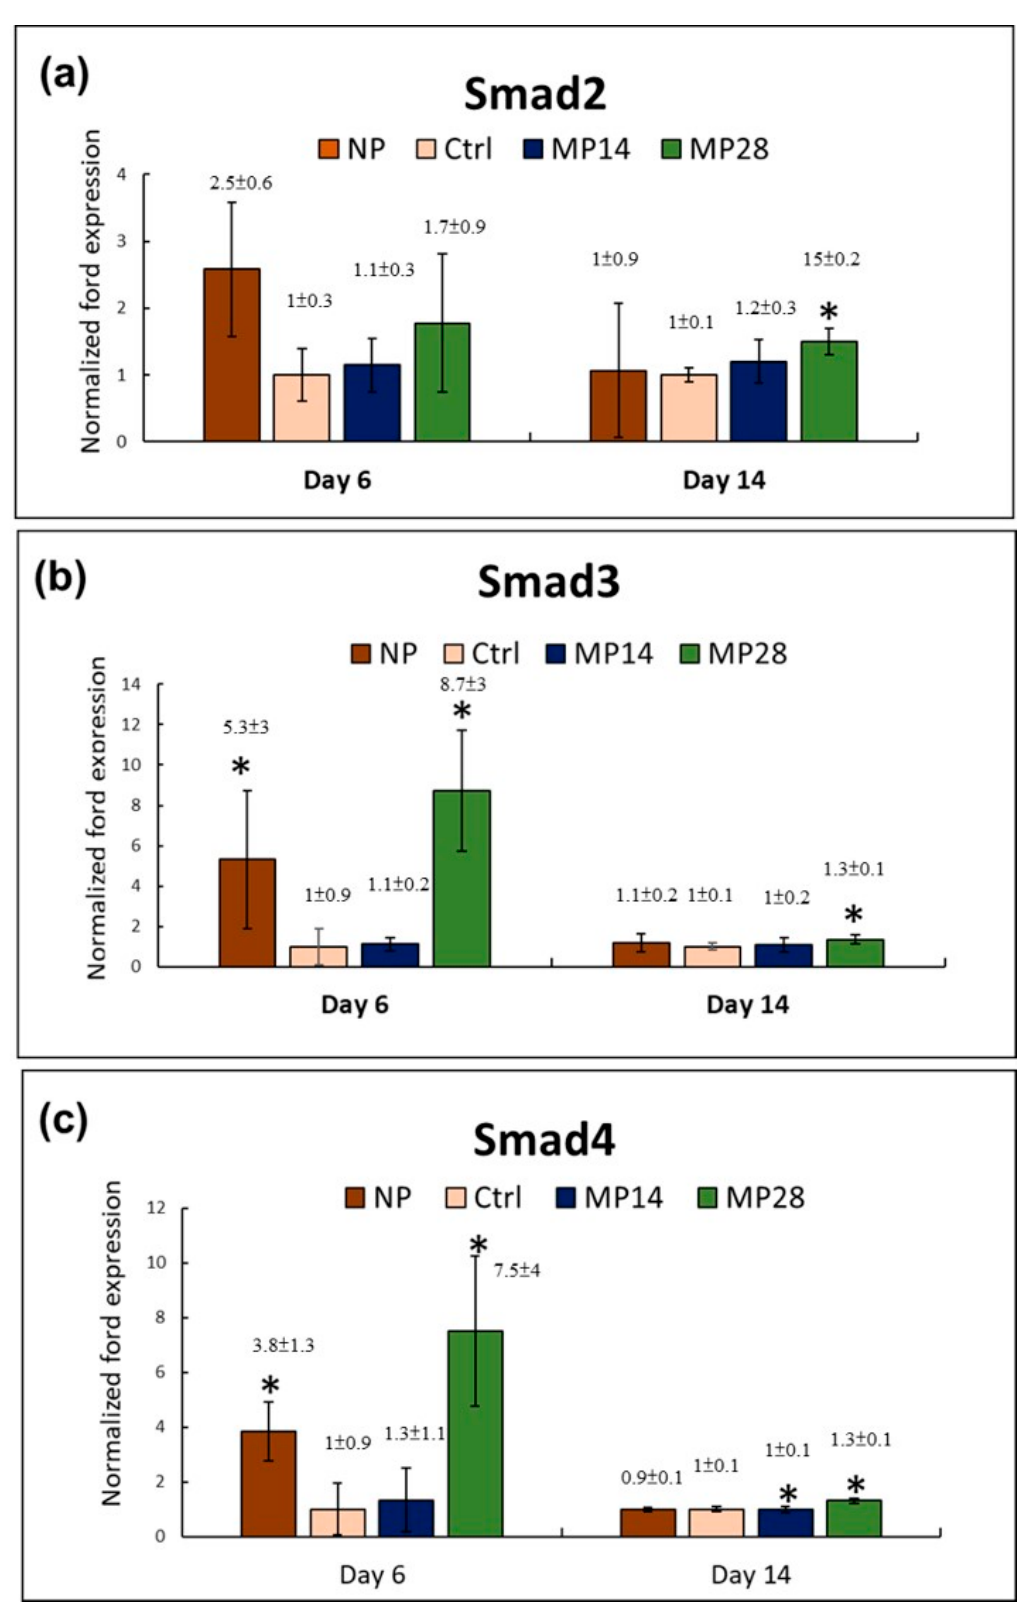
Figure 6. mRNA expressions of ( a ) Smad2, ( b ) Smad3, and ( c ) Smad4 in the epidermal layer in wound tissues of the control, MP14, MP28, and NP groups on days 6 and 14 after treatment. Gene expression levels are relative to those in the control group, which are defined as 1. The values presented are the means ± SDs ( n = 6), with * p < 0.05 and compared with the control group.